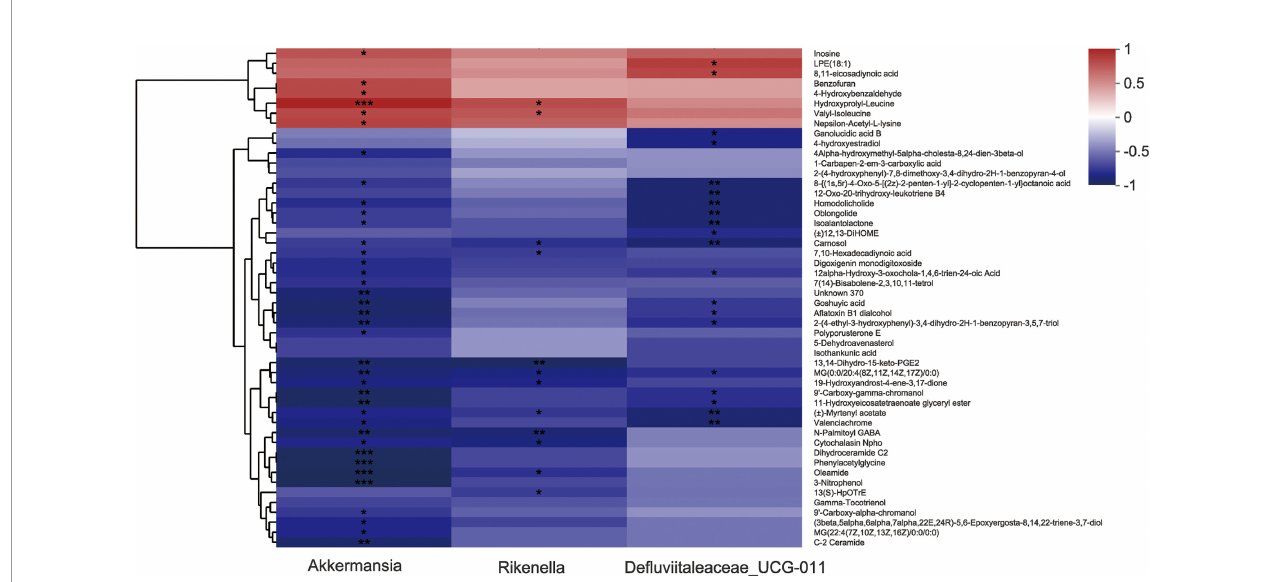
FIGURE 7 | Correlation analysis between several speci fi c intestinal microbes and altered fecal metabolites. * P <0.05, ** P <0.01, and *** P <0.001 (the AS-IV vs. the model